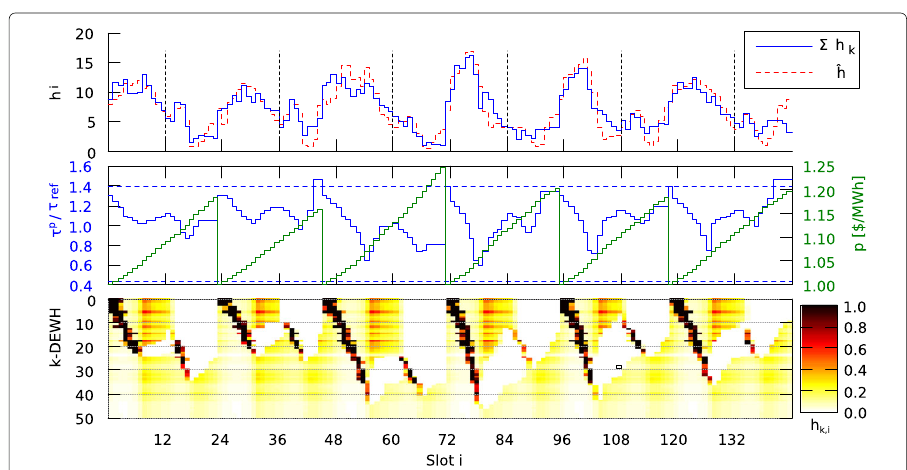
Fig. 5 Results with receding horizon and price reset for January 1-6